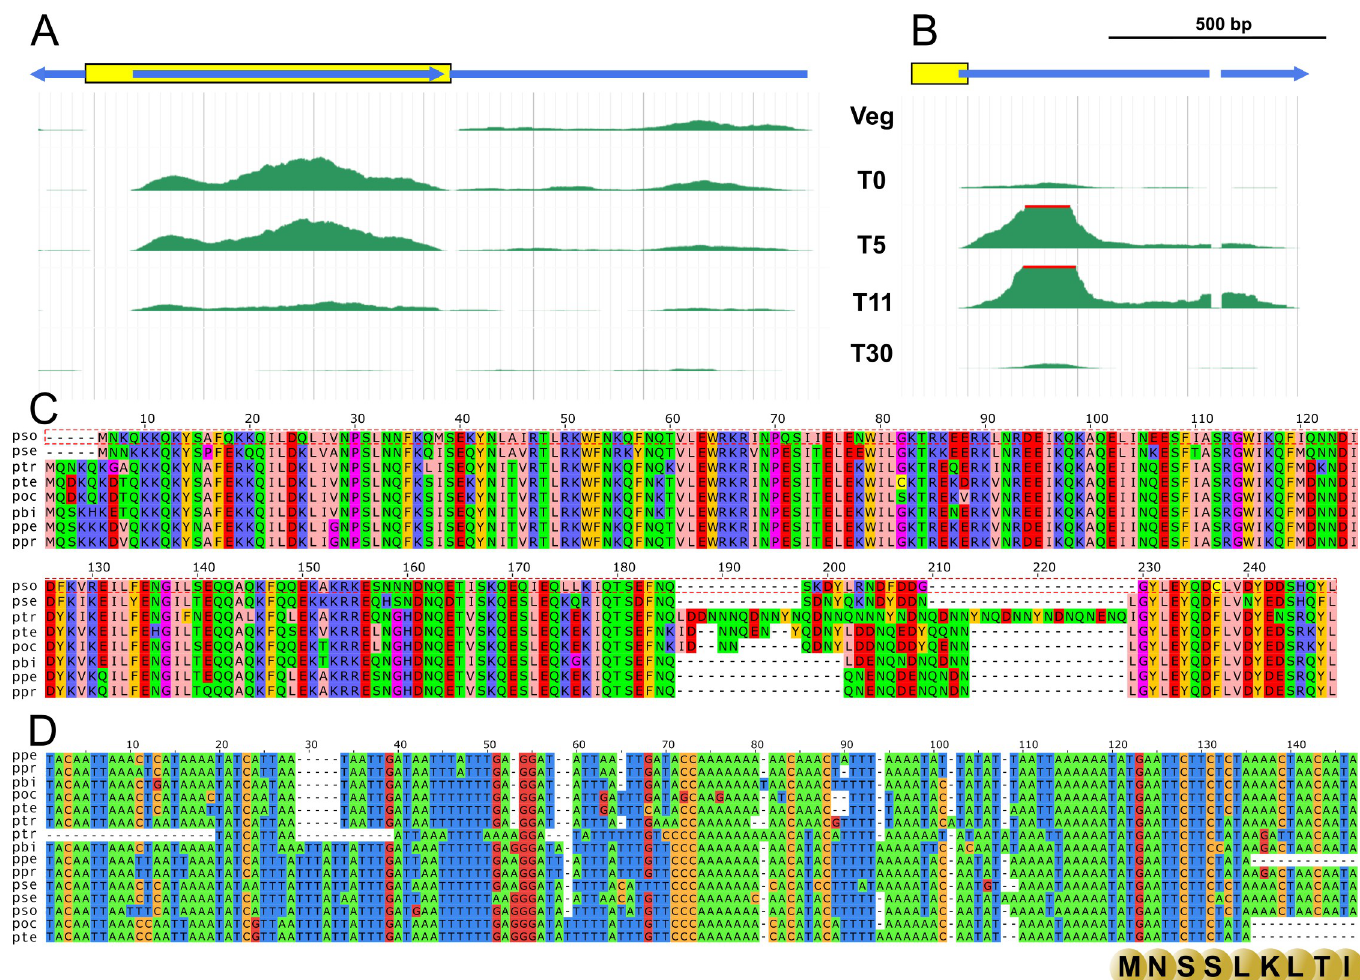
Fig 5. Examples of highly conserved co-orthologous IESs. (A) Cluster 4968 corresponds to a set of co-orthologous IESs that contain a gene (blue), oriented in the opposite direction with respect to the gene (blue) in which the IES is inserted (yellow). The IES-embedded gene encodes a protein belonging to a family of CENP-B DNA- binding proteins and is likely of cellular origin. RNA-Seq data (shown here for the Paramecium tetraurelia member of this cluster: IES.PTET.51.1.16.324097) show that this gene is expressed at meiosis, with mRNA steady-state levels strongly decreasing before most genome-wide IES excision occurs [36]. ( B) Cluster 9405 corresponds to a set of co-orthologous IESs that contain the promoter and the start codon of a gene (blue) encoding a protein of unknown function. The IES is drawn in yellow. RNA-Seq data (shown here for 1 P . tetraurelia member of this cluster: IES.PTET.51.1.28.104046) indicate that this gene is expressed at the time genome rearrangements occur, with a peak in steady-state mRNA level at T11, when IES excision peaks [36]. (C) Alignment of the proteins encoded by IESs from cluster 4968. (D) Nucleotide alignment of co- orthologous IESs from cluster 9405. The ATG start codon and first few amino acids encoded by the IES are shown below the alignment. [IES IDs in the alignments, from top to bottom (C): IES.PPENT.87.1.080.374281, IES.PPRIM.AZ9-3.1.072.352290, IES.PBIA.V1_4.1.0053.93462.rc, IES.POCT.138.1.076.348969, IES.PTET.51.1.61.348482, IES.PTRED.209.1.7180000129326.89420.rc, IES.PTRED.209.1.7180000129337.349035, IES.PBIA.V1_4.1.0022.293968, IES.PPENT.87.1.047.444829,